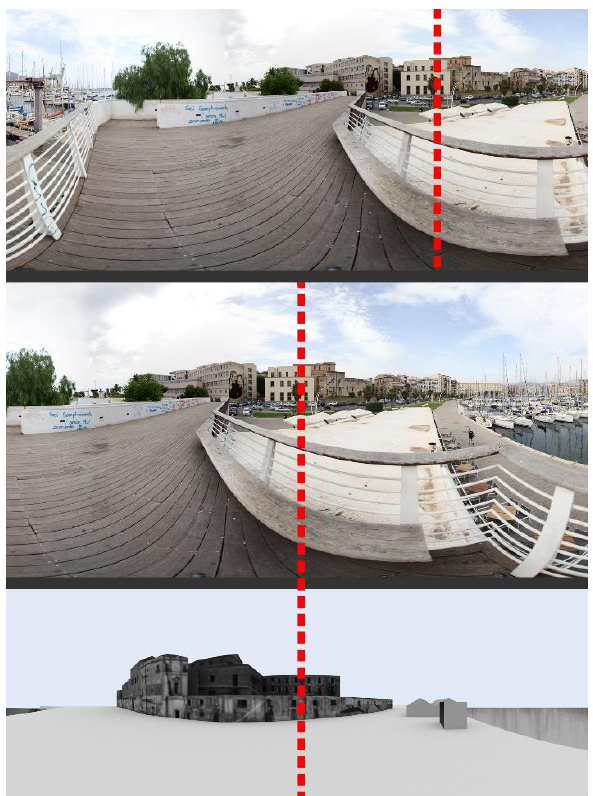
Figure 16: The orientation of the real panoramic image is shifted to match the orientation of the virtual panoramic